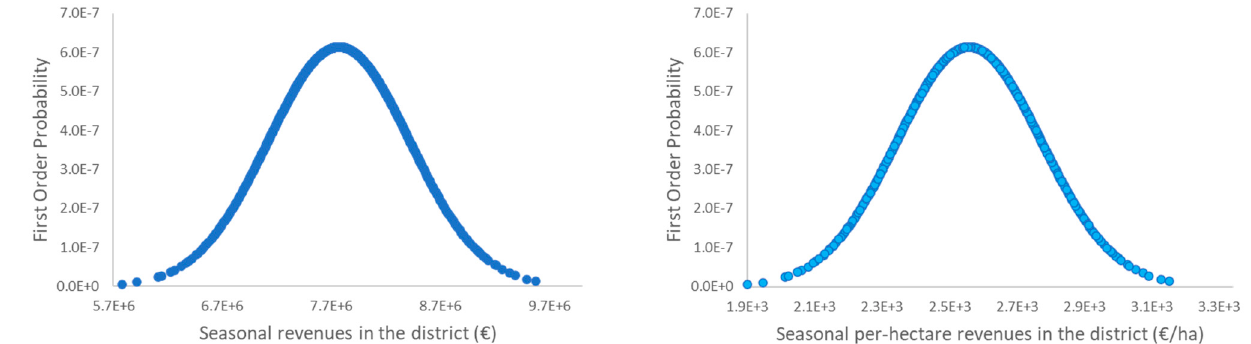
Figure 3. I Order PDF of revenues in the district for the period March–April. Table 1. Parameters of the I Order PDF representing risk in the district for one period. Average Standard Deviation € € /ha € € /ha